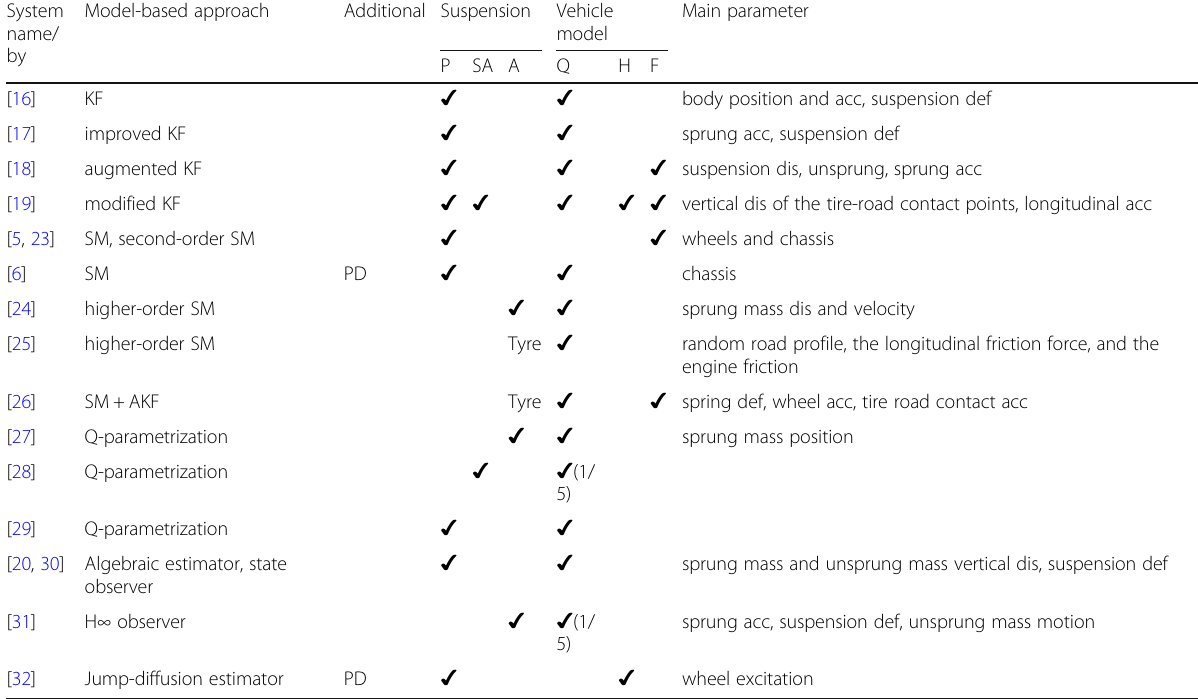
Table 1 Summary of model-based methods for road profile reconstruction function System name/